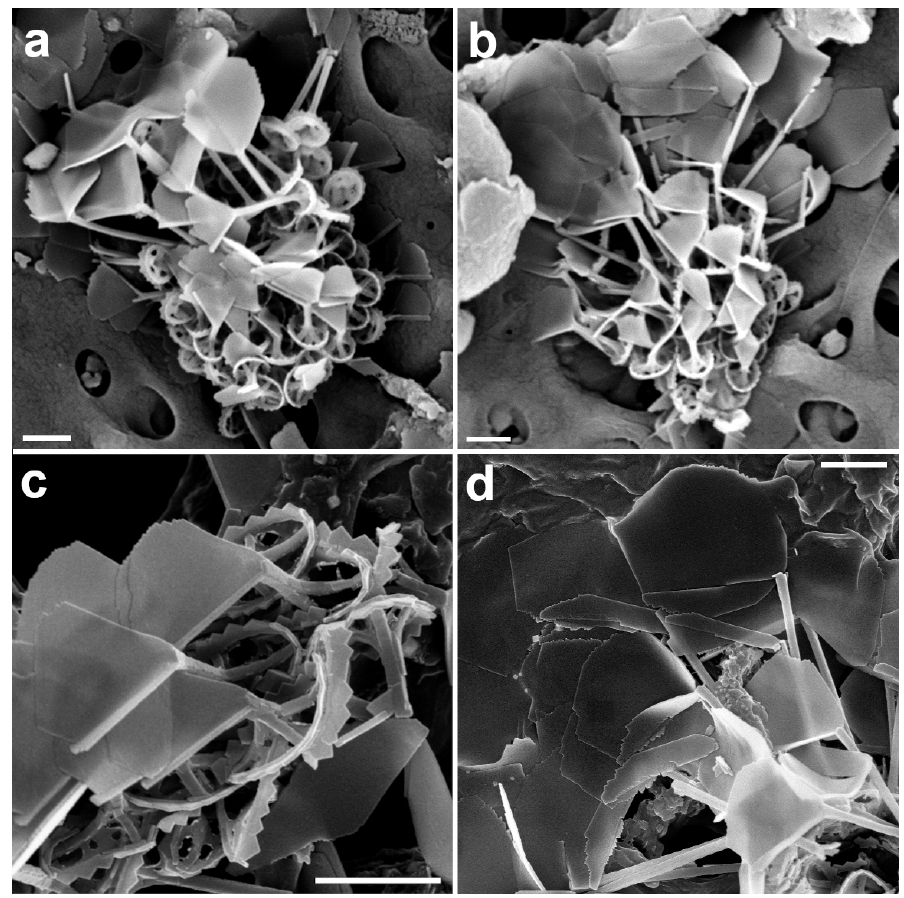
Figure 13. Pappomonas vexillata . (a, b) Complete coccospheres (GoA, 18 April 2017, 140 and 60m). (c) Close-up of body coccoliths showing the two-tiered calyx with a triangular blade and a stick-like element on the left, as well as the central area and rim structure on the right side. (d) Circum-flagellar coccoliths with long processes and the two types of unevenly sized blade-like elements ( c, d : GoA, 11 September 2017, 120m). Scale bars: